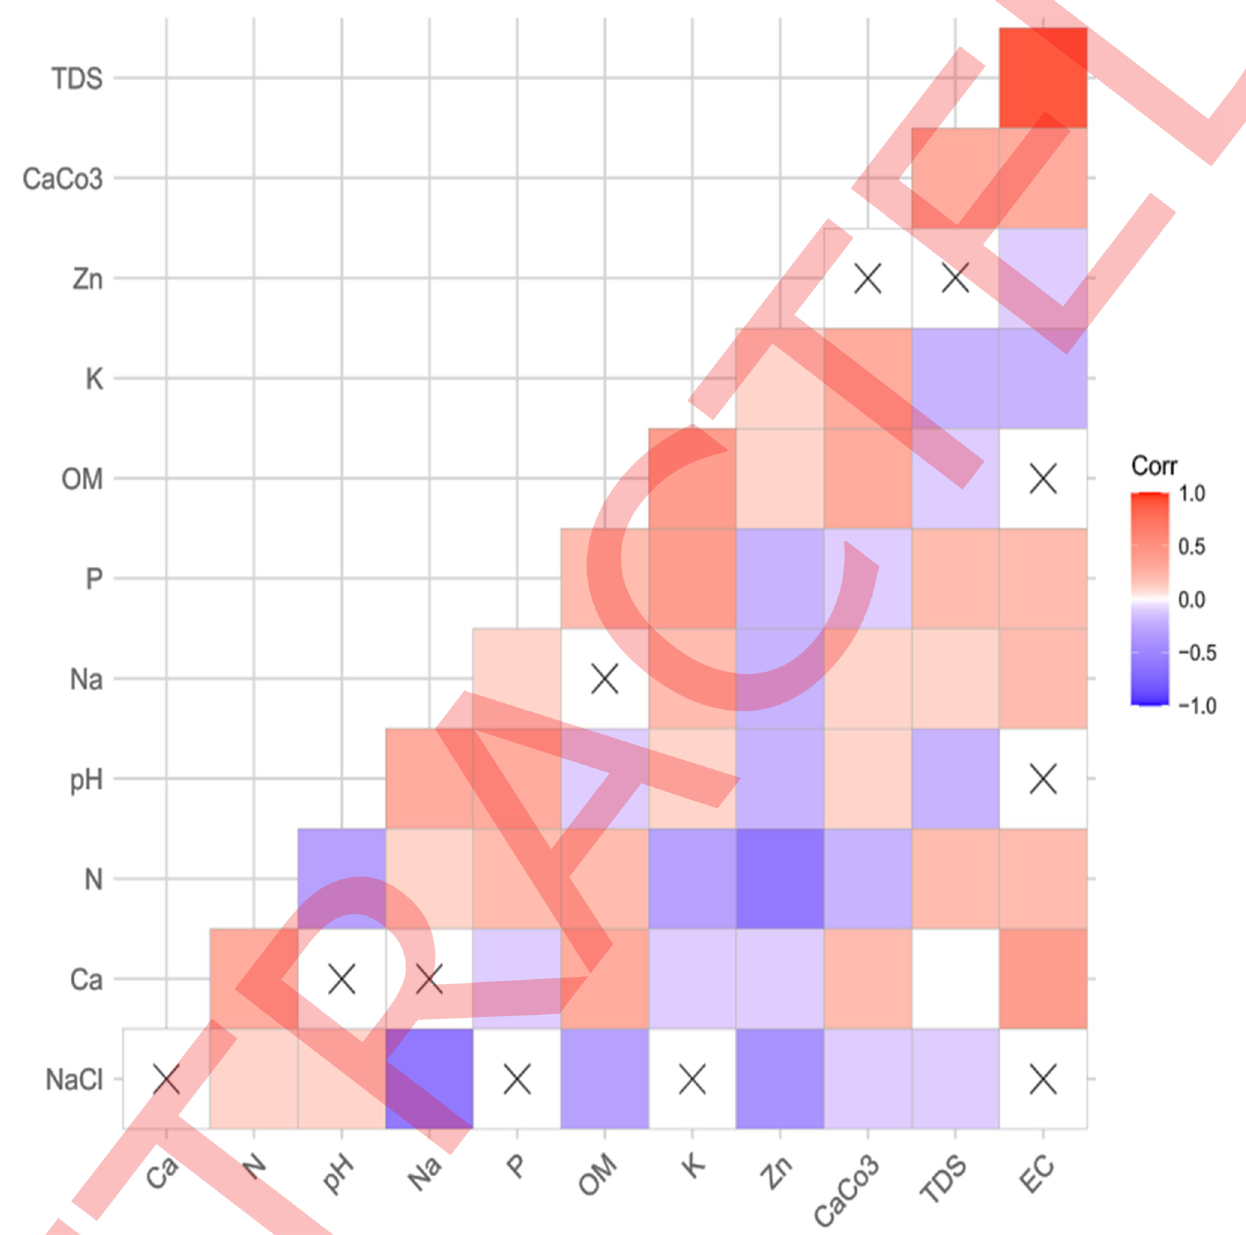
Fig 6. Correlation among various edaphic factors. Abbreviations used are TDS (total dissolved solids); OM (organic matter); EC (electrical conductivity).